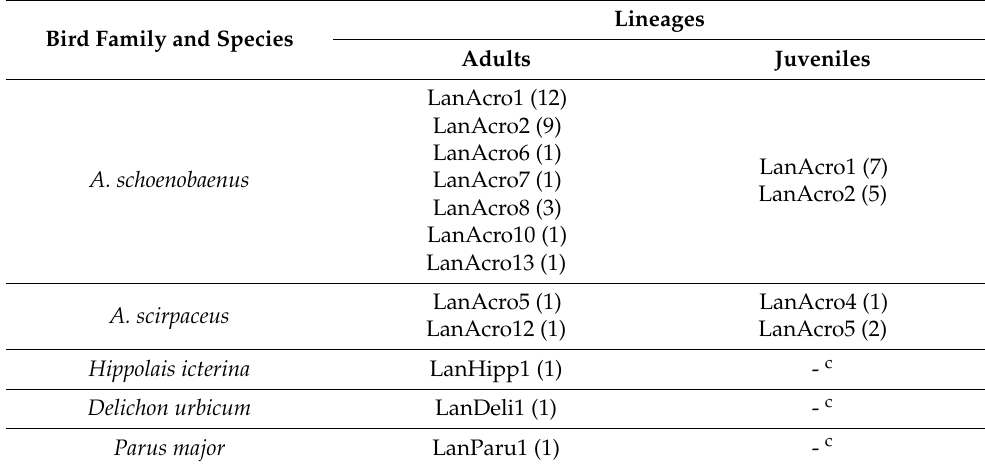
Table 3. Cont . Bird Family and